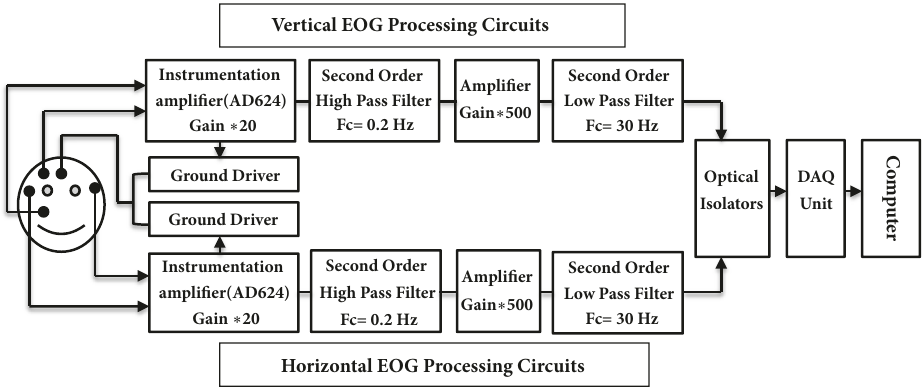
Figure 4: Developed EOG acquisition